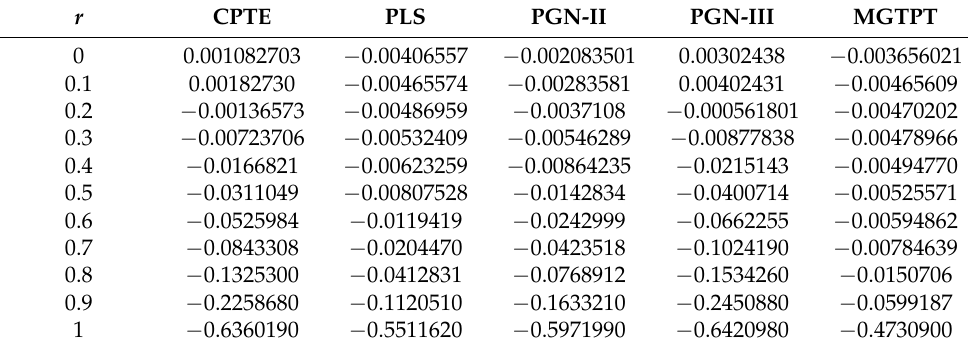
Table 5. The hoop stress variation σ ϑϑ under photothermal models.